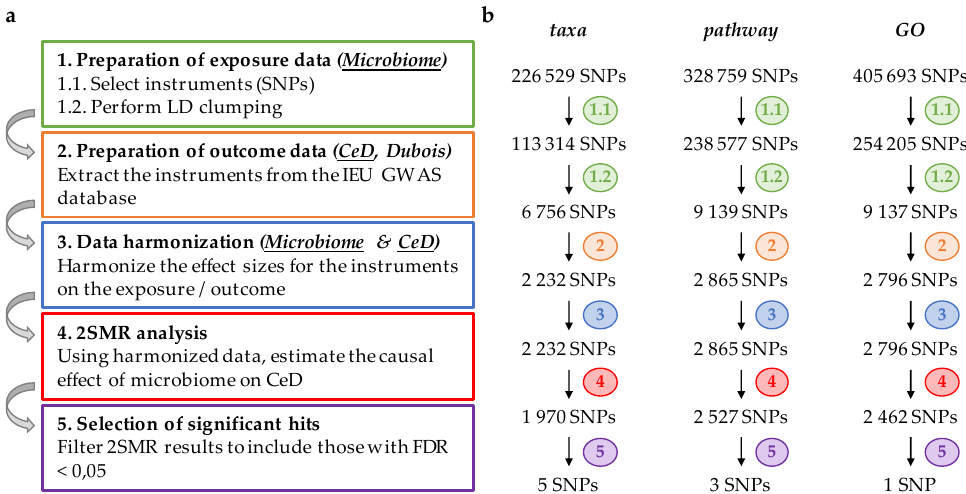
Figure 1. Schematic representation of two-sample Mendelian randomization analysis (2SMR) using Bonder microbiome and Dubois celiac disease (CeD) genome-wide association study (GWAS) as exposure and outcome datasets, respectively. ( a ) Flowchart of the step-by-step analysis: after preparing exposure data (Step 1), outcome data is extracted (Step 2), both datasets are harmonized (Step